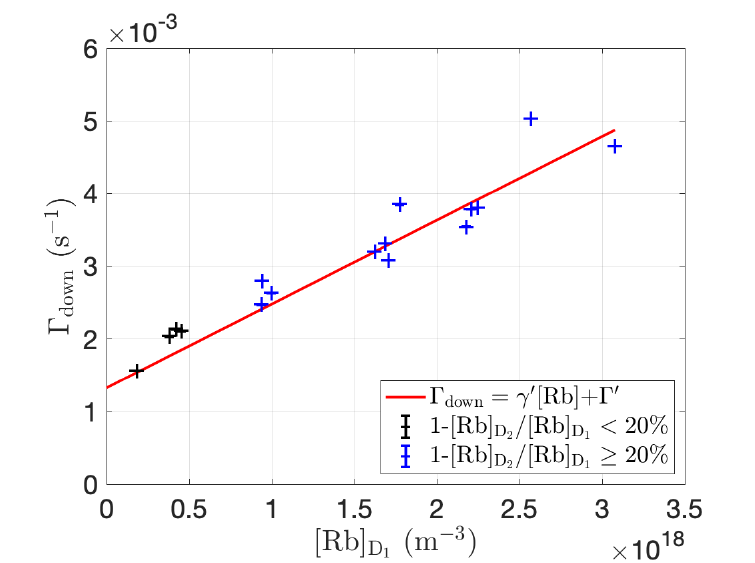
Figure 6. 129 Xe relaxation rate, Γ down , as a function of [ Rb ] for 1 g Rb main body cell. [ Rb ] measured from D 1 line absorption. γ (cid:48) = 1.2 ± 0.1 × 10 − 21 m 3 s − 1 and 1/ Γ (cid:48) = 13 ± 2 min. > 20% difference in [ Rb ] [ Rb ] D 1 and D 2 , suggestive of deviation from the Beer-Lambert law for D 2 absorption, occurs at (cid:38) 4 × 10 17 m − 3 and correspondingly [ Rb ] [ Rb ] D 2 measurement. accurate [ Rb ] D 1